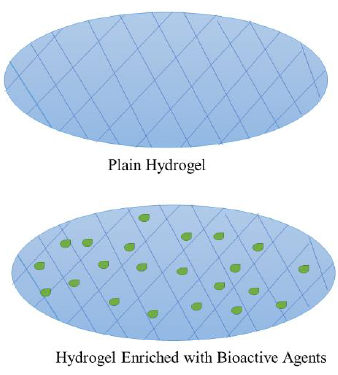
Figure 5. Plain and hydrogel loaded with bioactive agents.